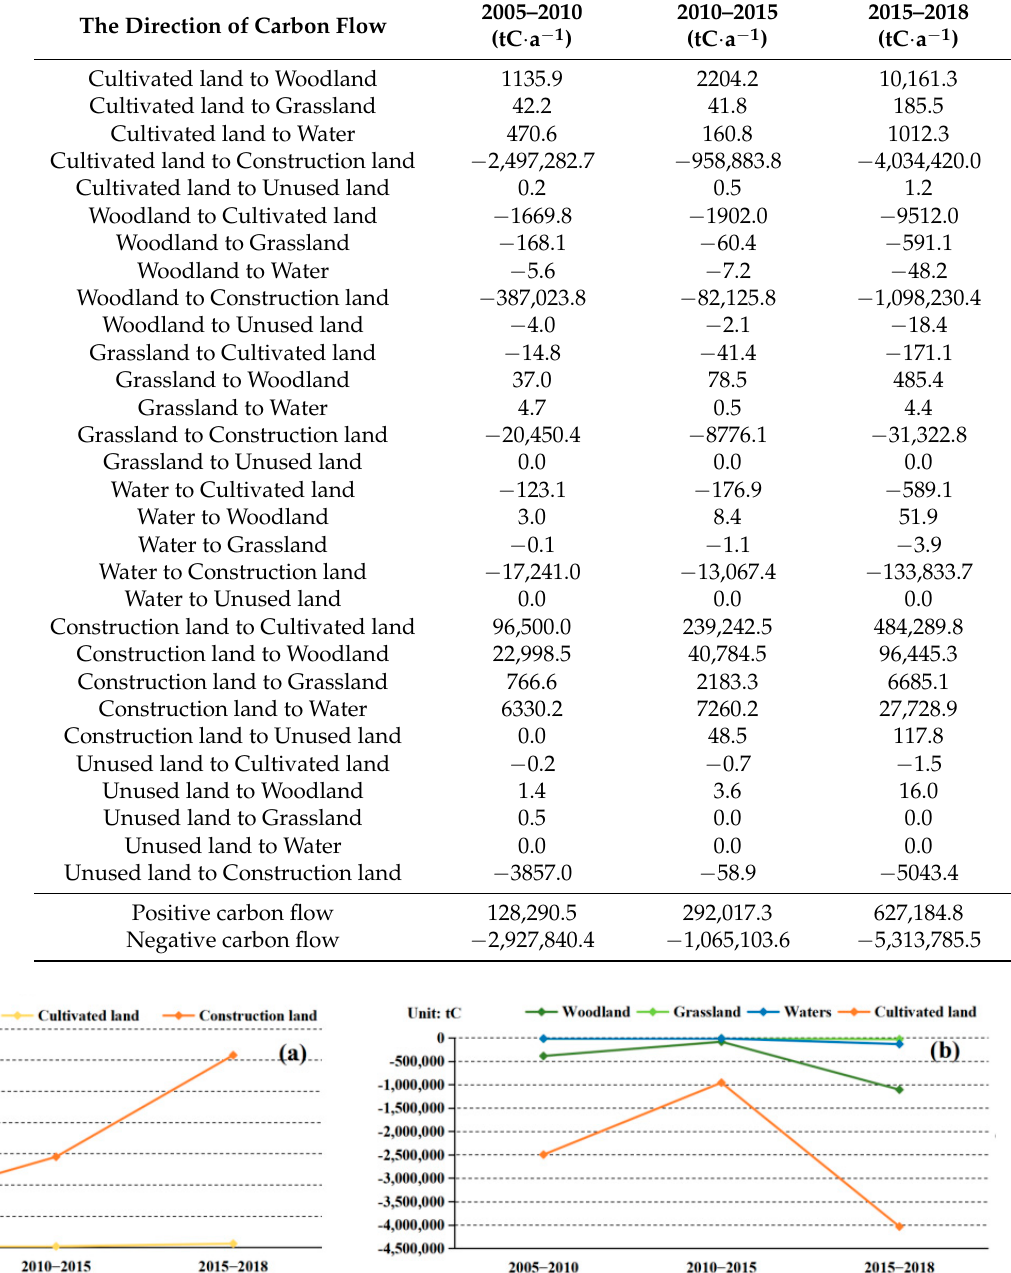
Table 8. Carbon flow from 2005 to 2018.